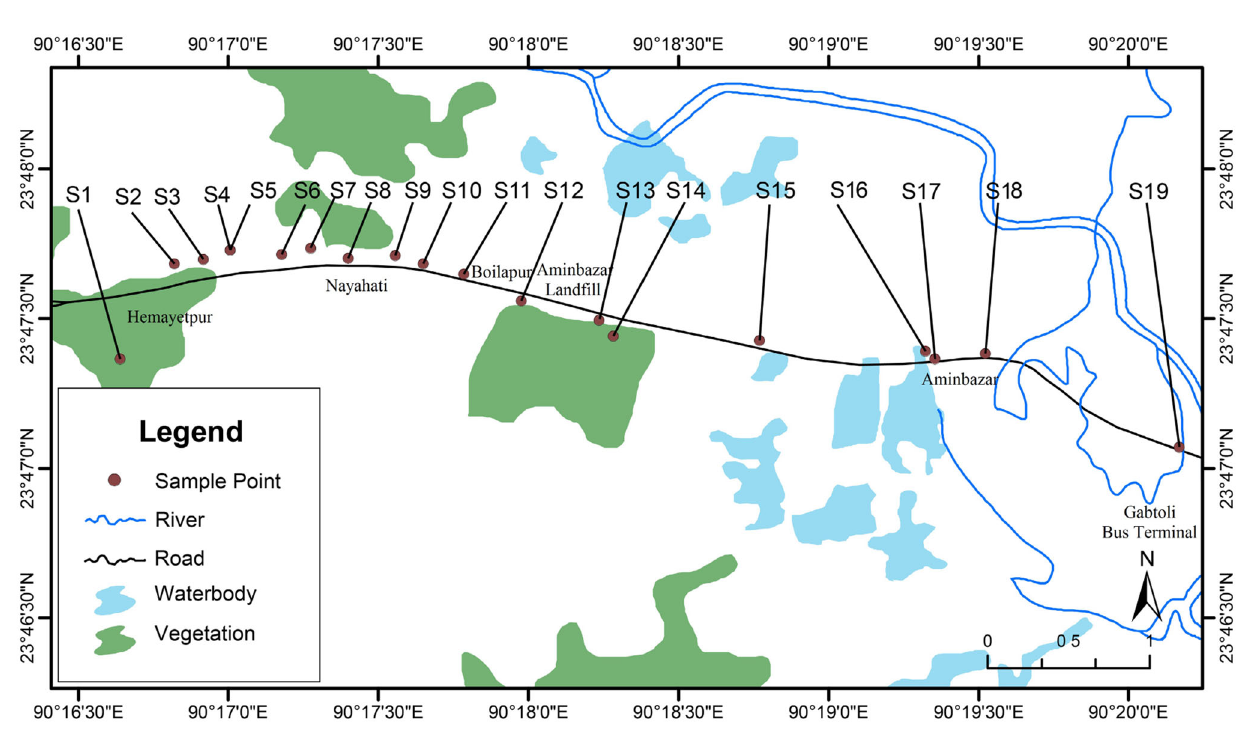
Fig. 1 Sampling location map of the study area